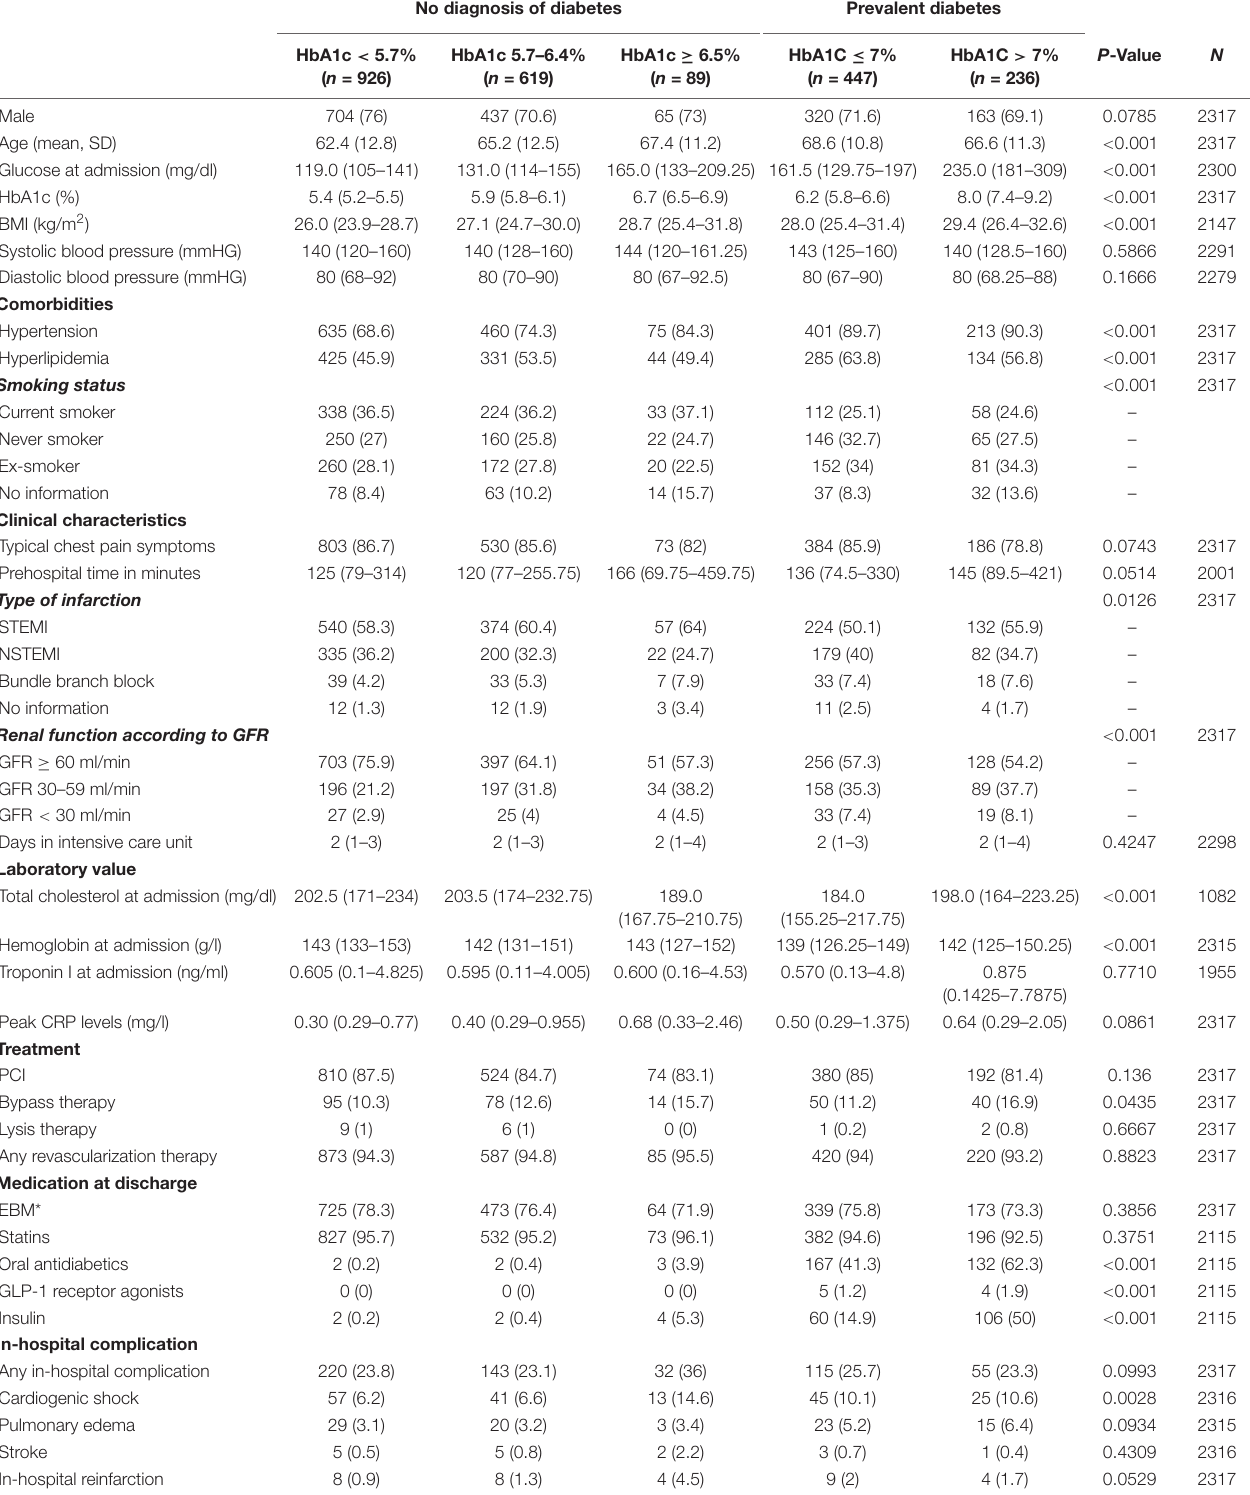
TABLE 1 | Baseline characteristics according to diabetes and